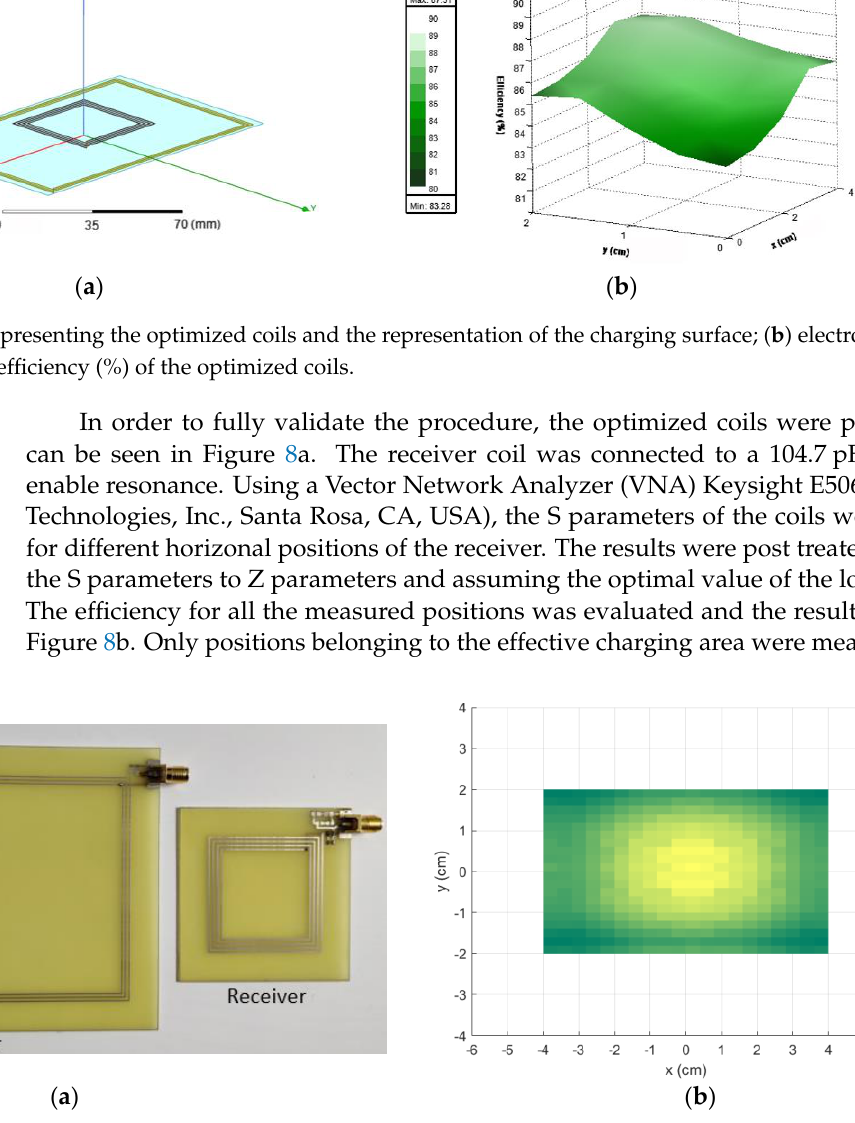
Figure 8. ( a ) The manufactured transmitter and receiver prototypes; ( b ) the experimental efficiency (%) results of the optimized coils for all charging area. Only positions inside the effective charging area were measured.